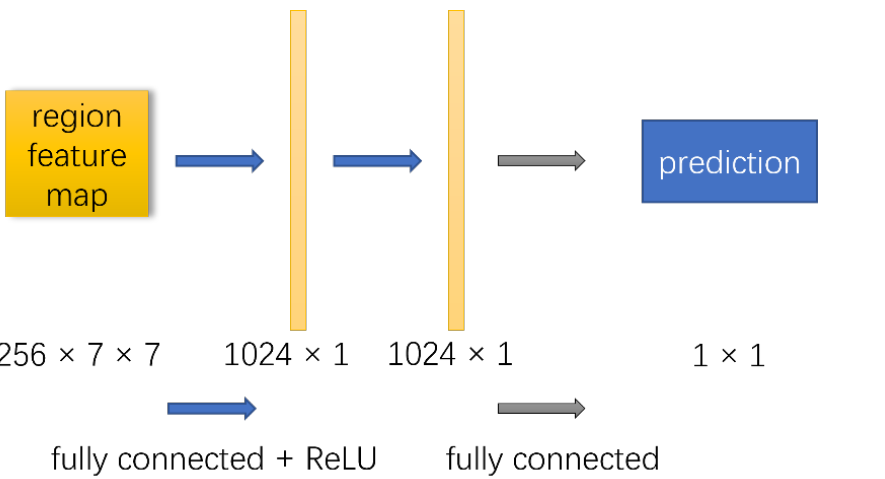
Figure 2. Main network architecture of proposed methods. Figure 3. Network architecture of BA branch and GFA branch. This figure is from [3].